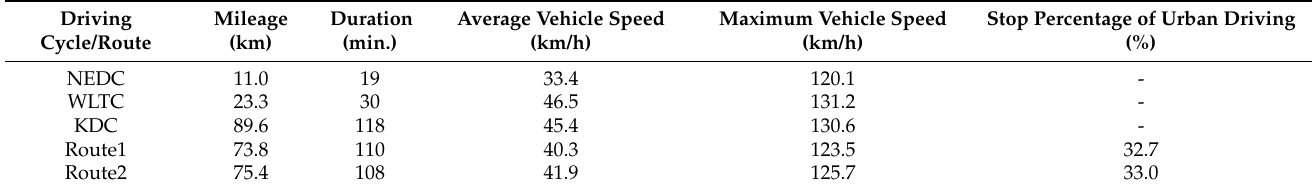
Table 2. Driving characteristics of on-road tests and laboratory cycles.